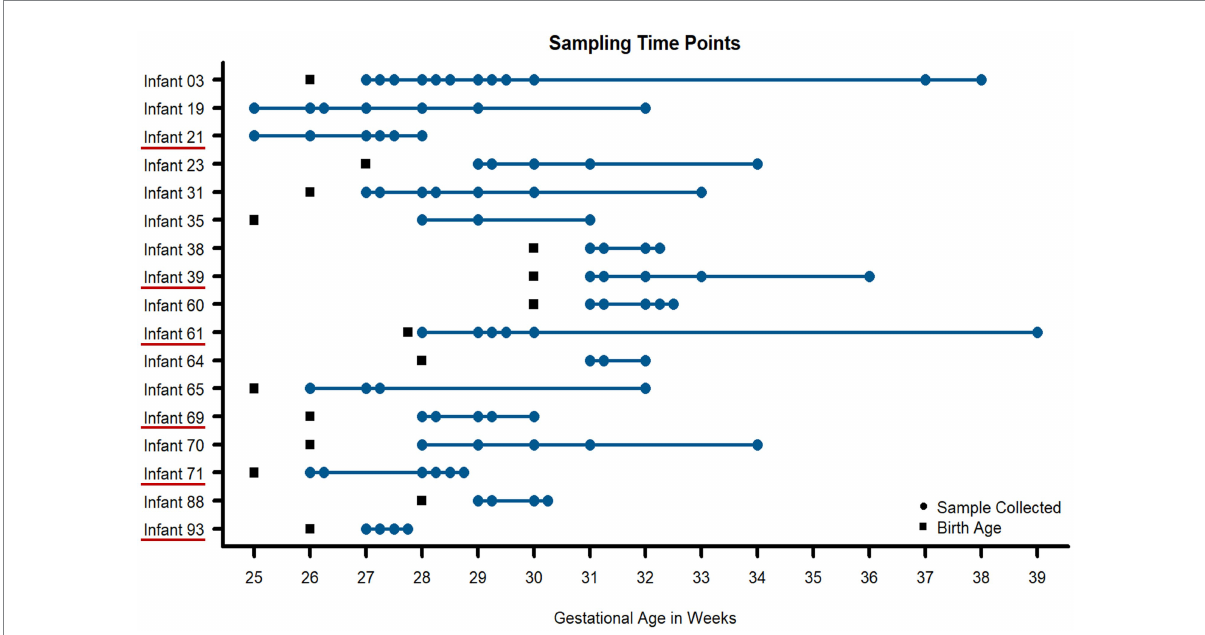
FIGURE 1 Fecal samples collected for metaproteomic measurements for all infants in the study. Using necrotizing enterocolitis (NEC) as a representative dysbiotic condition, 91 fecal samples (blue circles) were taken from 17 preterm infants over the first 90 days of life. Multiple time points were measured per infant to assess intraindividual variability over time. Six infants developed NEC during the early stages of life (underlined in red on the y-axis). Birth age (in gestational weeks) is noted for each infant with black